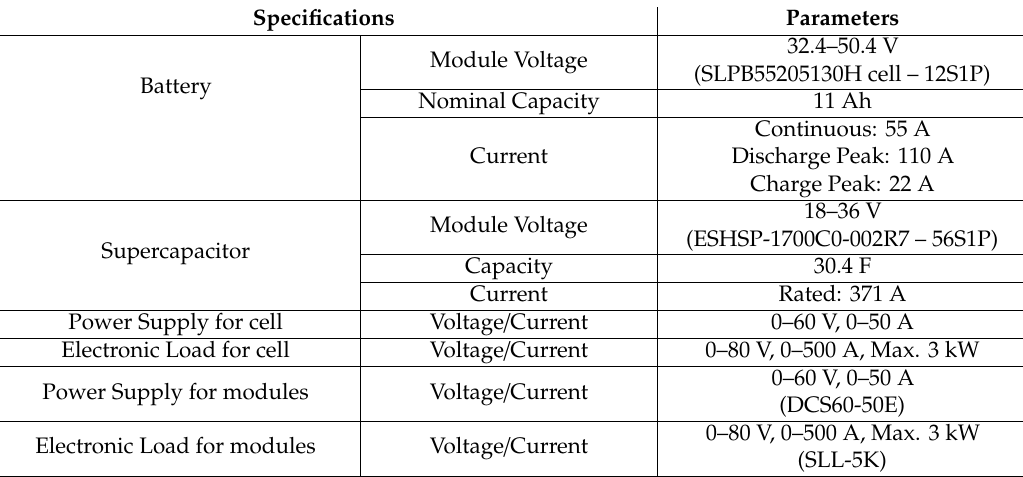
Table 1. Specifications used for experimental testing.